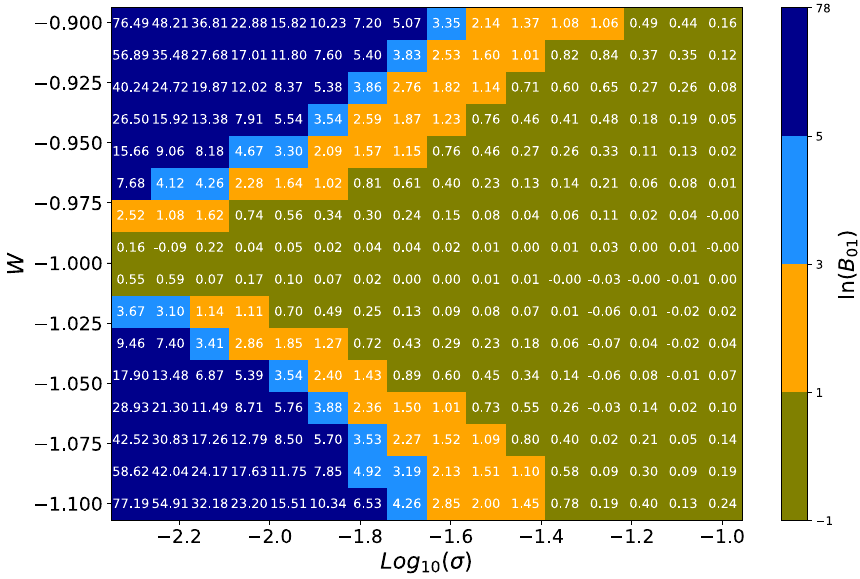
Fig. 1 The mean Bayes factor for the Λ CDM and wCDM using the first sampling strategy. Different colors show different criterion in Table